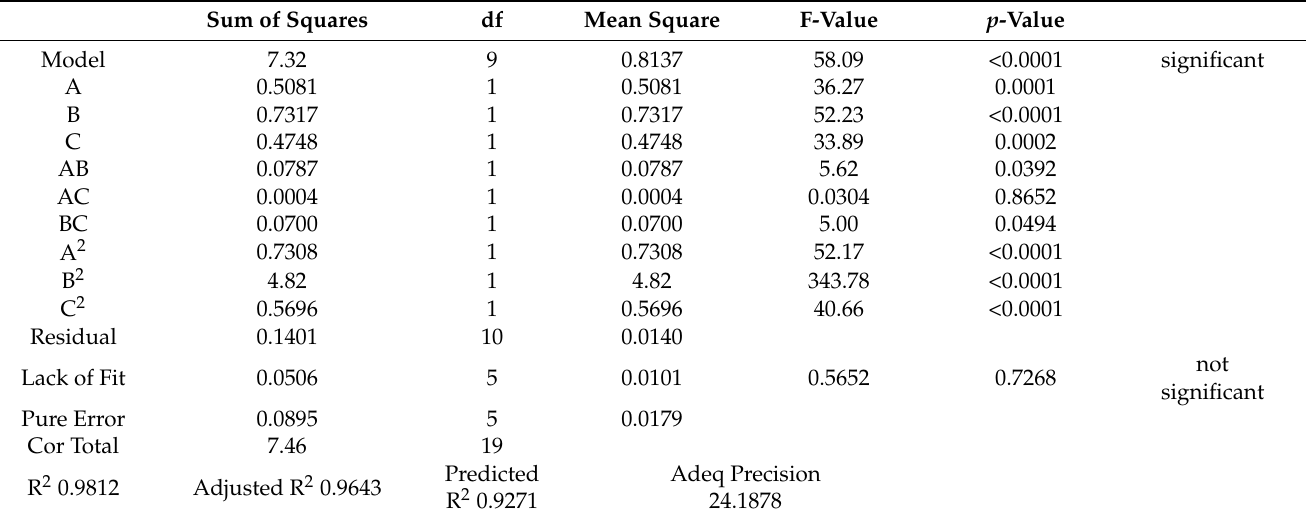
Table 4. ANOVA for Quadratic